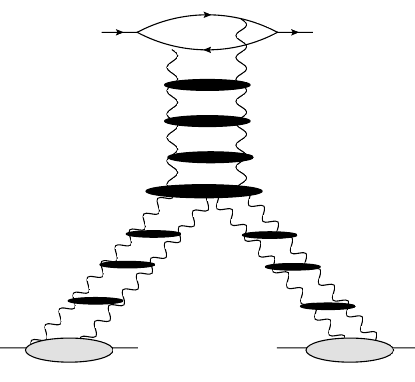
Figure 1 . The triple pomeron vertex.